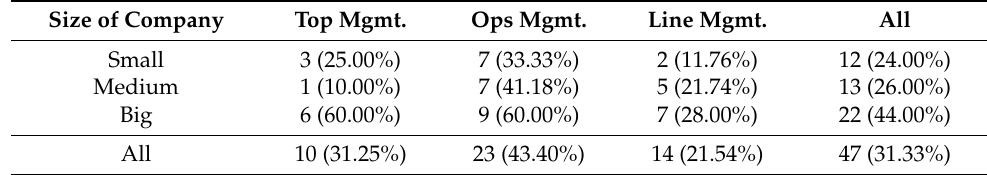
Table 3. Features of the research subjects with response rates. Size of Company Top